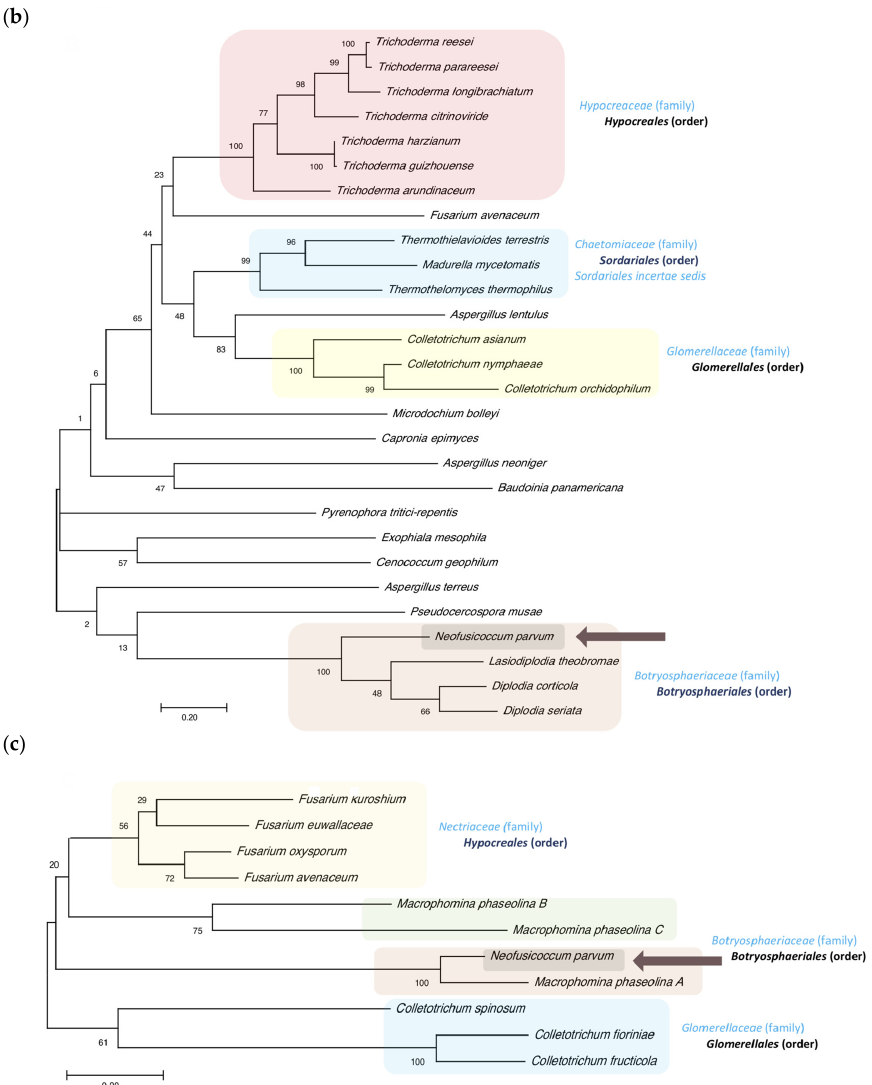
Figure 6. Phylogenetic analyses of NpCysRP1, NpCysRP2, and NpCysRP3 with orthologs from other fungal species. The phylogenetic trees were constructed using protein sequences with the maximum likelihood method and JTT matrix ‐ based